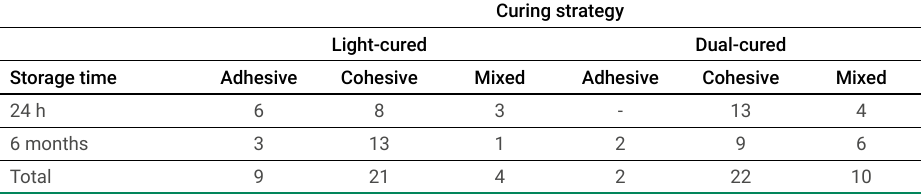
Table 4. Number of adhesive, cohesive, and mixed failures according to curing strategy of adhesive systems and storage times. Curing strategy Light-cured Dual-cured Storage time Adhesive Cohesive Mixed